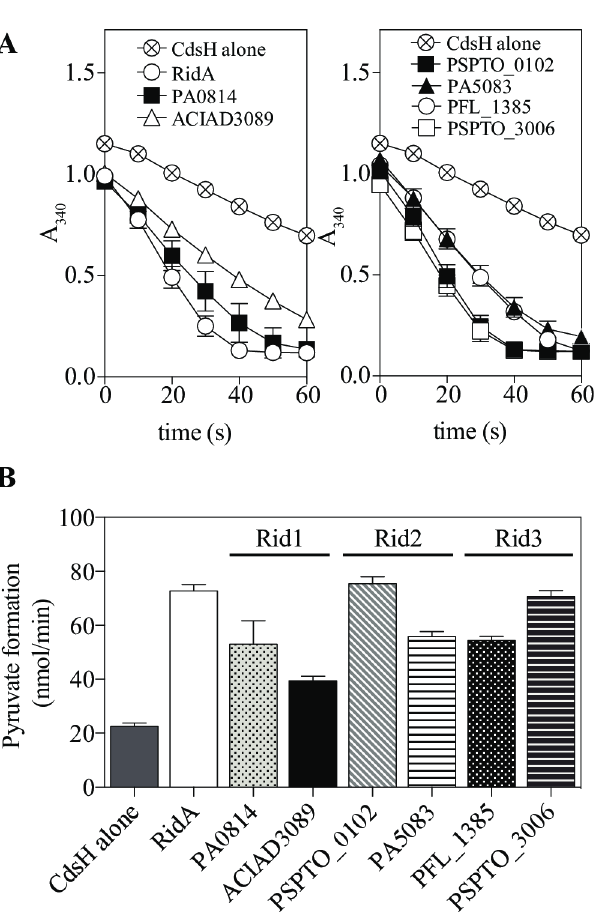
Fig 3. Rid proteins deaminate 2AA in vitro . Reactionmixtures (100 μ L) containedTris-HCl (100 mM, pH 8), NADH (250 μ M), pyridoxal5’-phosphate(30 μ M), pyruvate kinase/lactatedehydrogenase (5 Units) and purifiedcysteine desulfhydrase CdsH (0.27 μ M). Purified Rid protein (0.19 μ M) was added as indicated. (A) Absorbance was monitoredat 340 nm for 60 seconds followingthe addition of L-cysteineto 1 mM final concentration. Reactions containedCdsH and purifiedRid proteins as indicated. (B) The initial rate of pyruvate formation for each reactionwas calculatedusing the molar extinctioncoefficient( ε = 6,200 M -1 cm -1